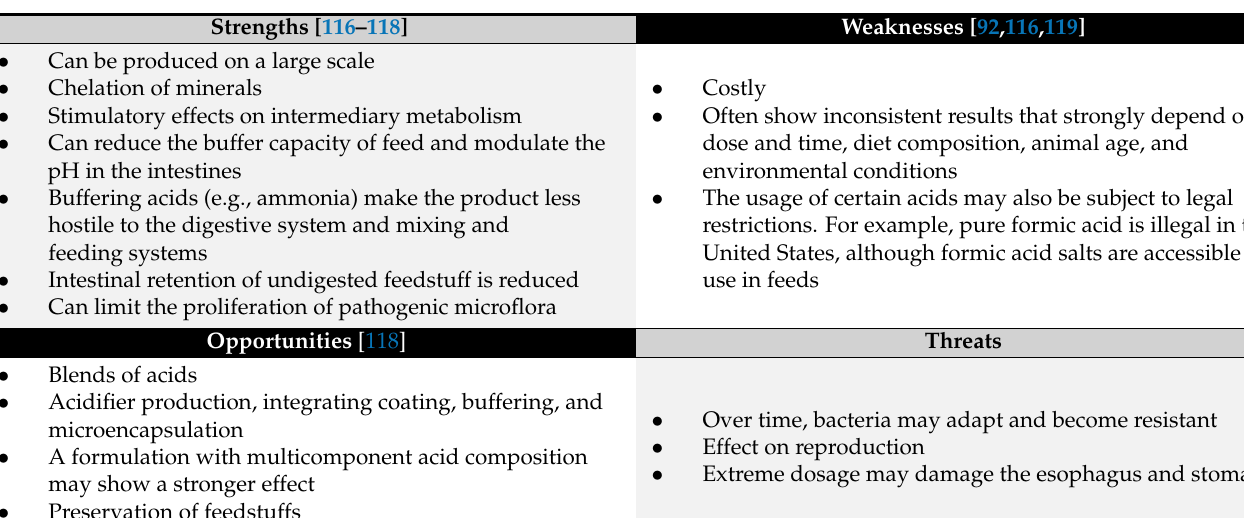
Table 3. SWOT analysis of